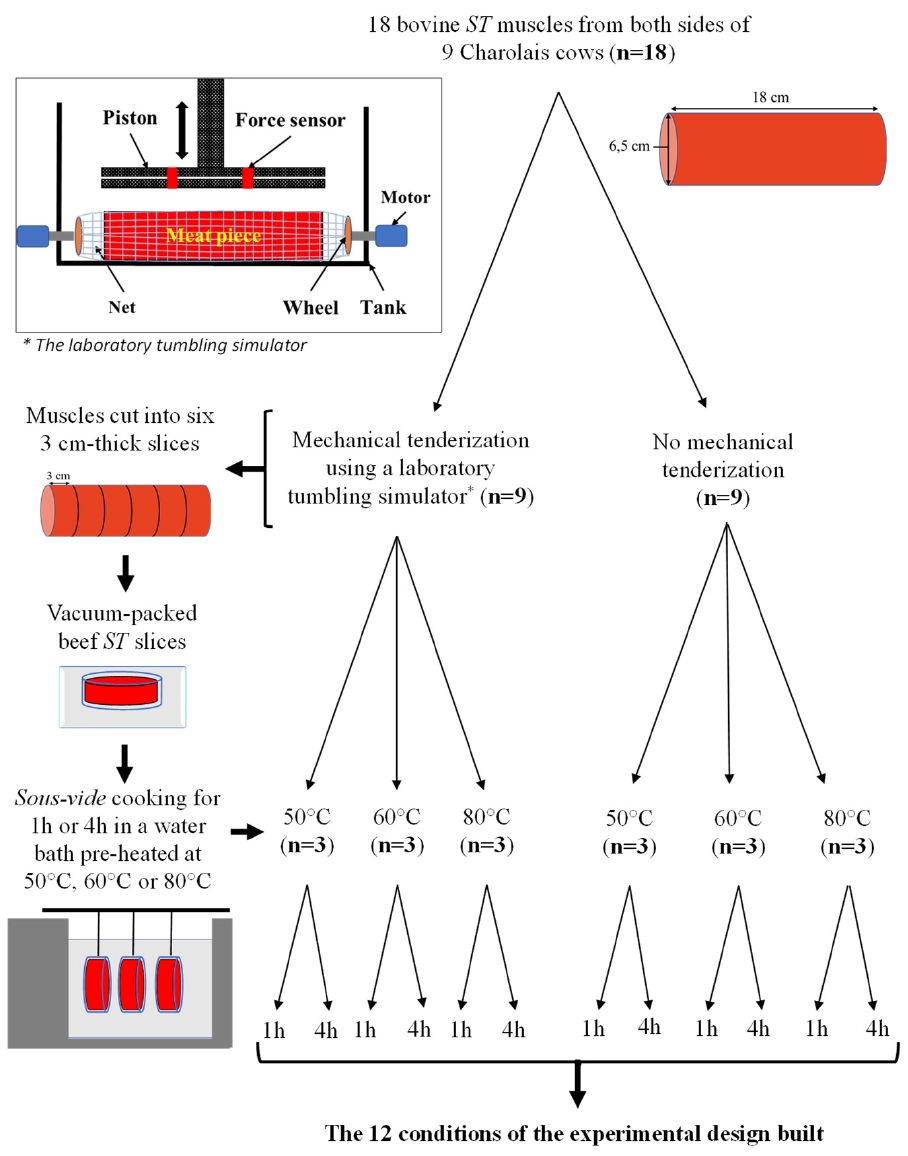
Figure 1. Schematic description of the experimental design built in this study.